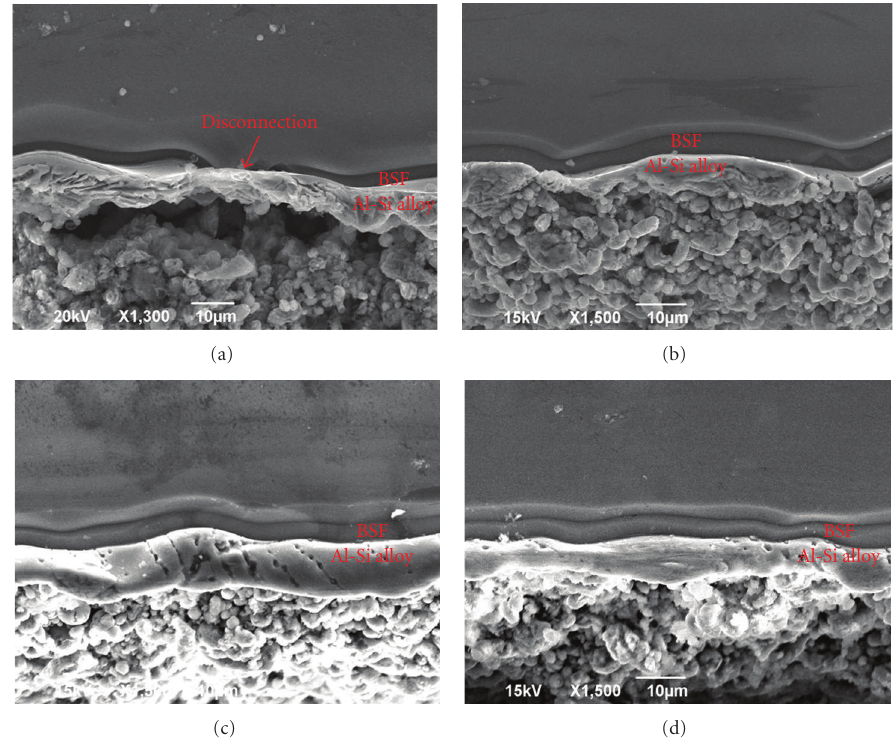
Figure 6: SEM comparison of cross-section of the BSF topology and Al-Si alloy layer of (a) ED0, (b) ED3, (c) ED6, (d) ED9.